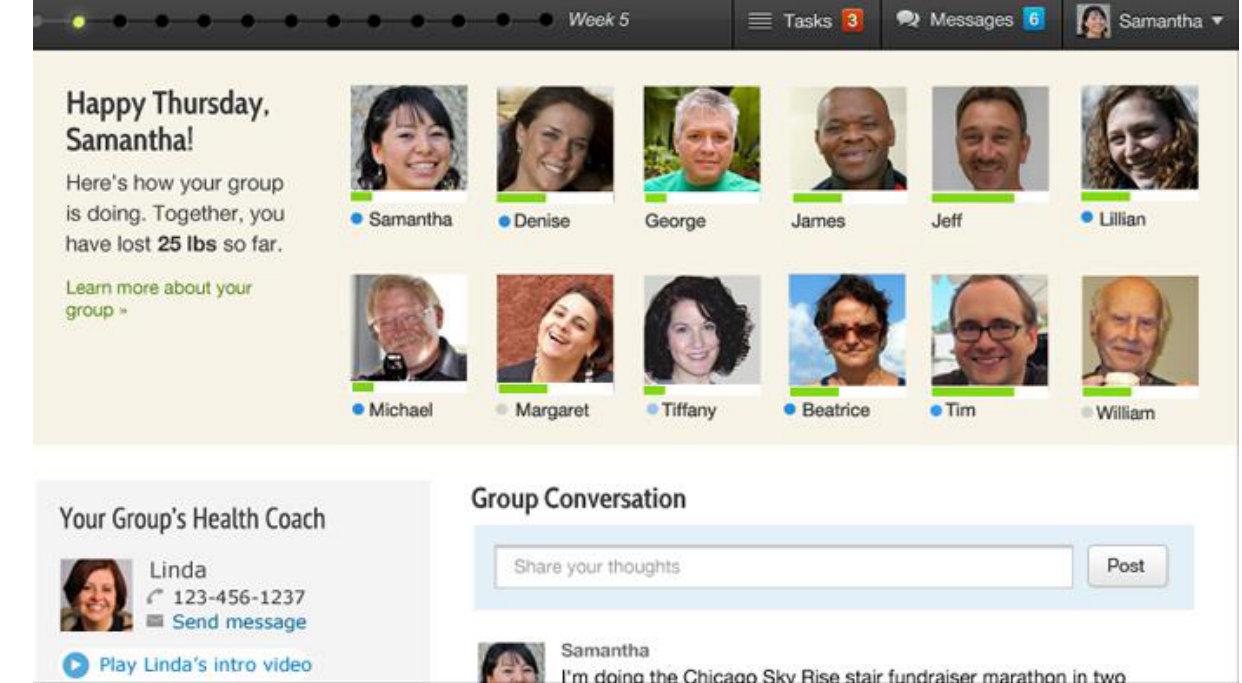
Figure 2. Prevent